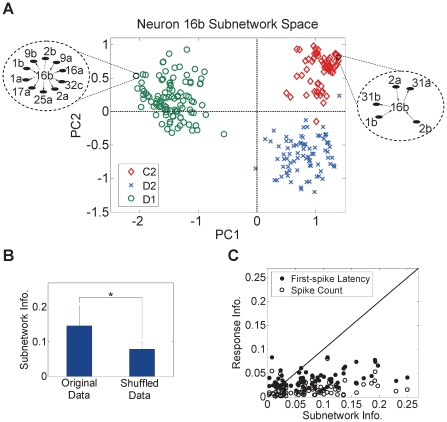
Individual neuron subnetwork information.(A) Network feature space of one sample neuron (Neuron 16b of rat R2) for 3 different whiskers (C2, D1 and D2). Each dot corresponds to the projection of one network onto a 2-dimension principal components (PC1 and PC2) feature space. (B) Normalized information in the individual neurons' networks inferred for the shuffled data versus the original data (mean ± SD). * P = 0, two-sample t-test. (C) Normalized information in first-spike latency and spike count versus information in the networks of each neuron. Each dot corresponds to one neuron. Black diagonal line represents equal information. Network information was corrected for any statistical bias by subtracting the network information computed for each neuron from the shuffled data in (B).